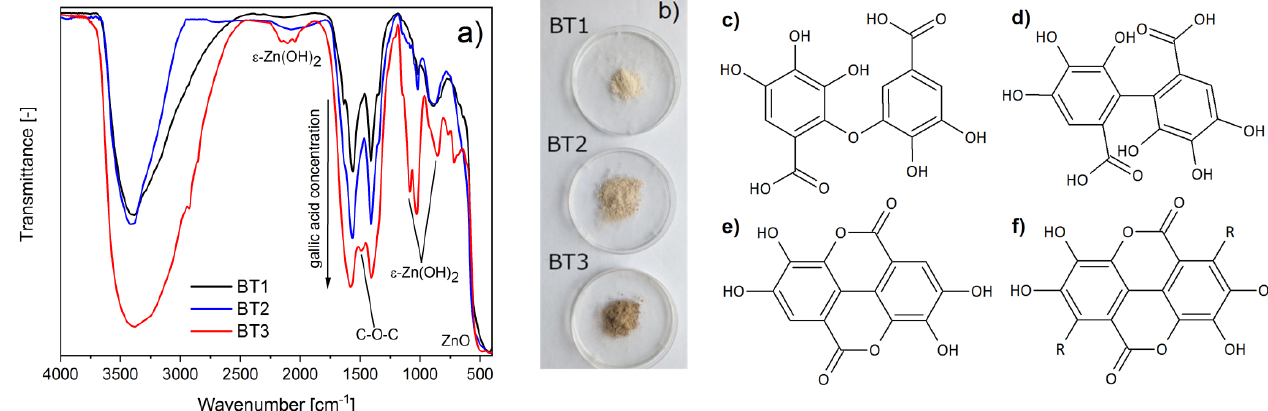
Figure 1. ( a ) FTIR spectra of the samples; ( b ) images of the samples; gallic acid autoxidation products: ( c ) C–O dimer, ( d ) C–C dimer, ( e ) ellagic acid, ( f ) gelate-based polymer.